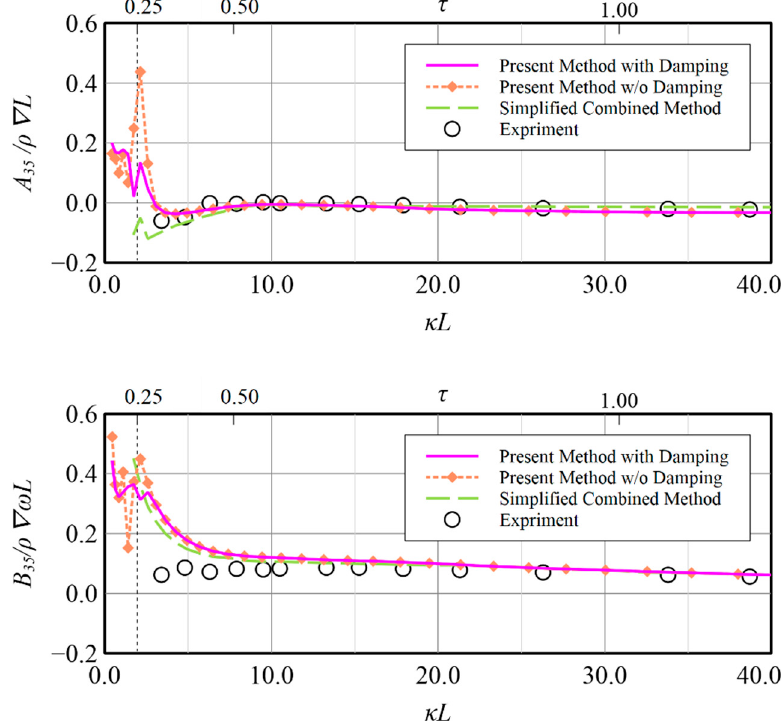
Figure 18. Pitch-induced-heave added mass and damping coefficient at F r = 0.18.